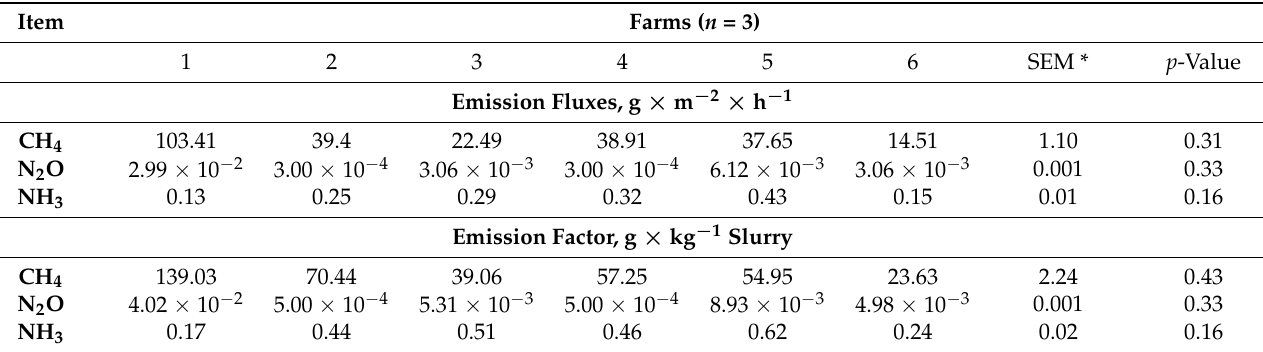
Table 2. Emission fluxes and emission factors in the